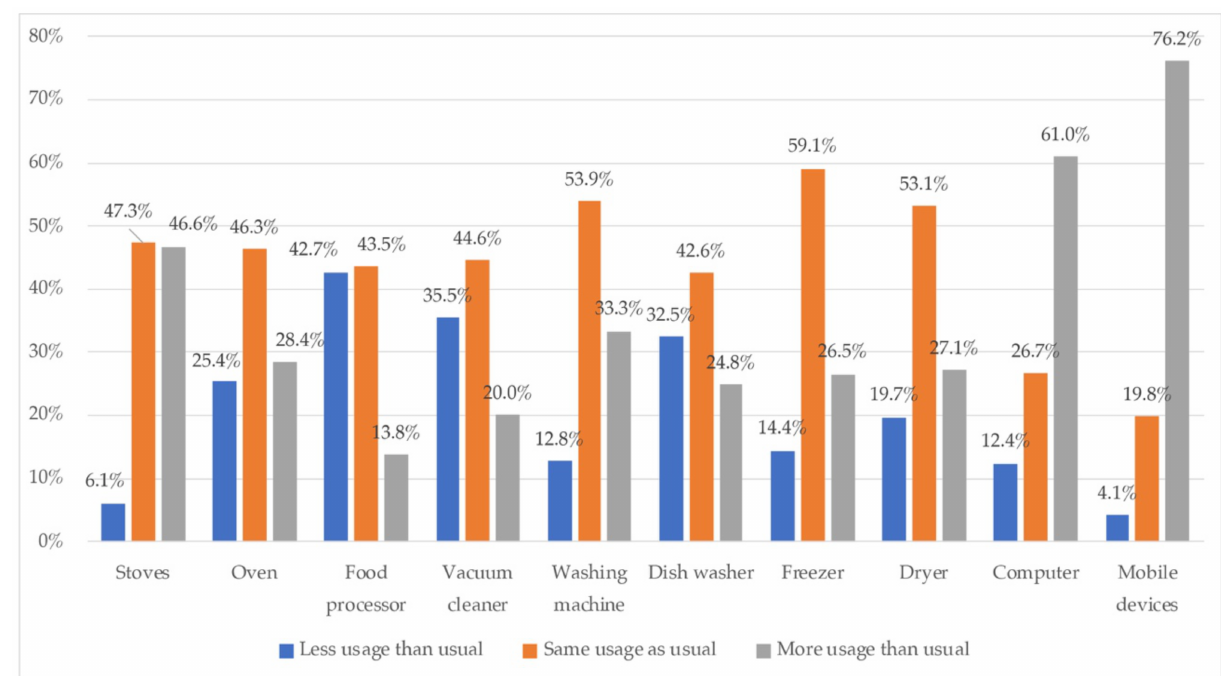
Figure 12. Comparison of frequency of use related to appliances in the home before and during the study